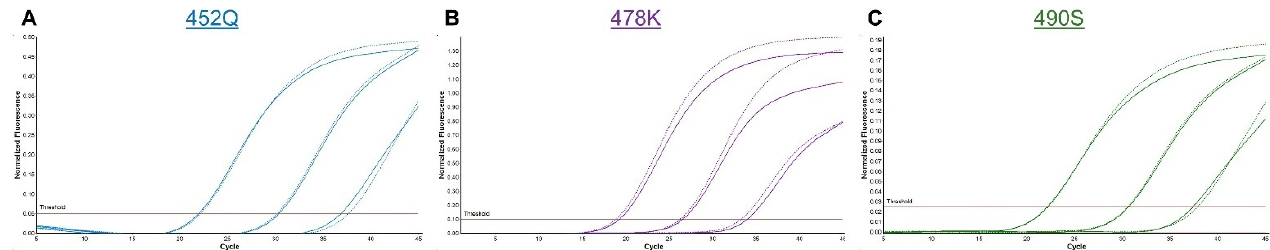
Figure 2. Addition of the 478K probe did not impact the signal from 452Q or 490S probes. Amplification curves are shown for 100-fold dilutions of C.37 (lambda) and B.1.617.2 (delta) samples tested together in a single run. The results were similar for ( A ) 452Q and ( C ) 490S mutations in C.37 with the probe for 478K (solid curves) or without (dotted curves). Results for B.1.617.2 were similar with the 478K probe ( B ) used in singleplex (dotted curves) or triplex reactions (solid curves). Nonspecific signals were not detected in any channel.